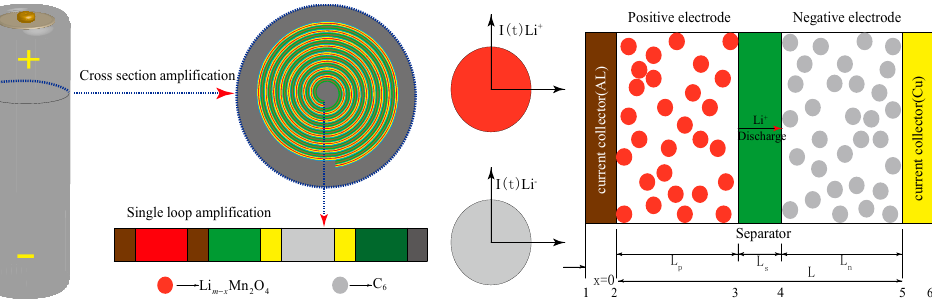
Figure 1. Simpli fi ed charging–discharging model of lithium-ion ba tt ery. Figure 1. Simplified charging–discharging model of lithium-ion